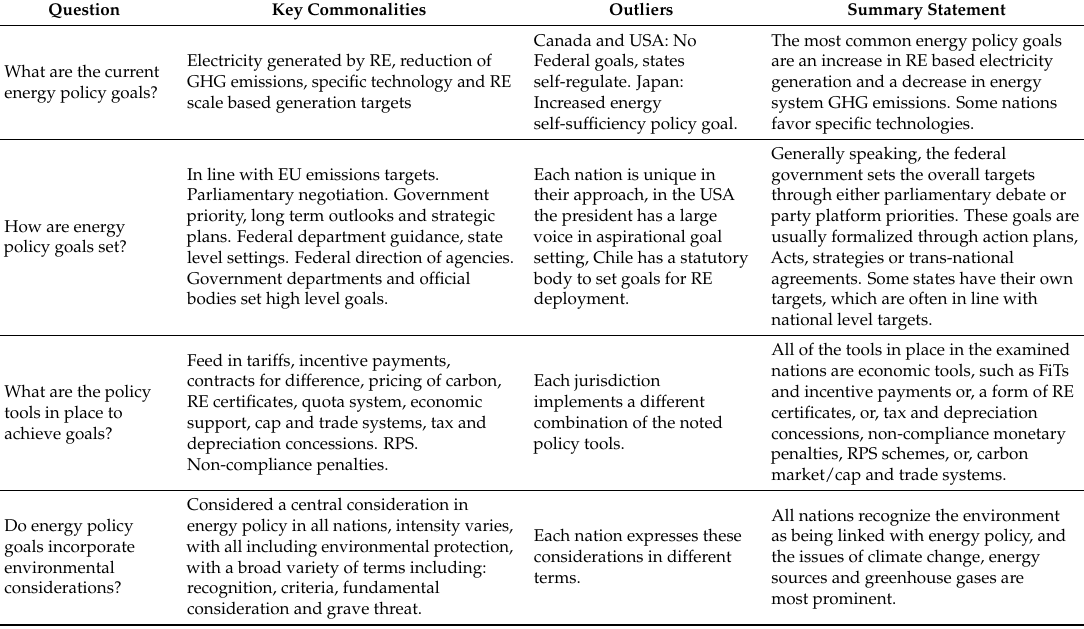
Table 8. Energy policy goals and considered factors QCA data